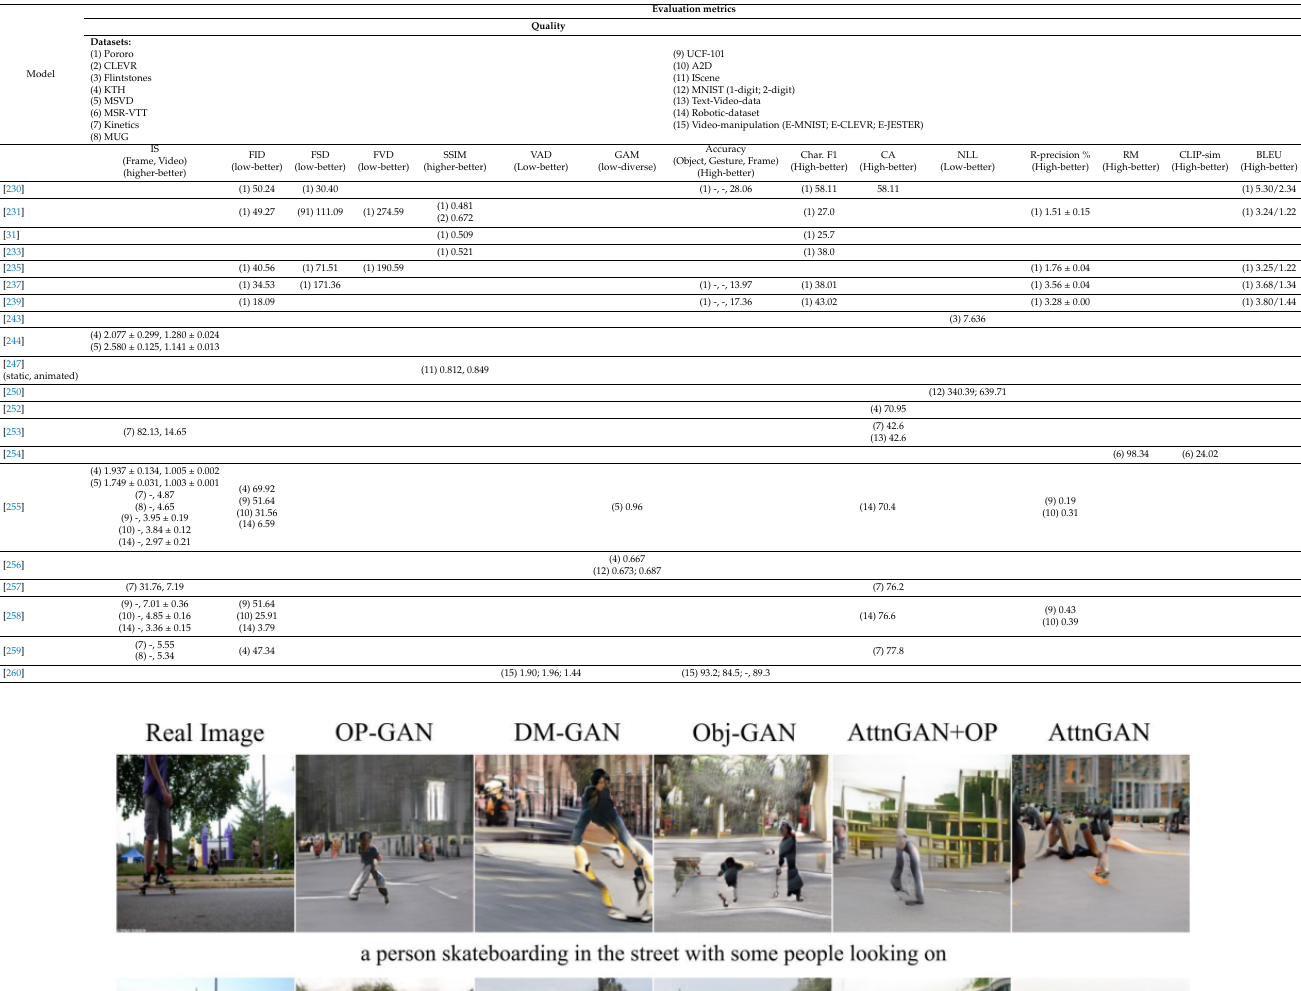
Table 5. Similar to image model evaluation metric table, but represents story and video tasks.